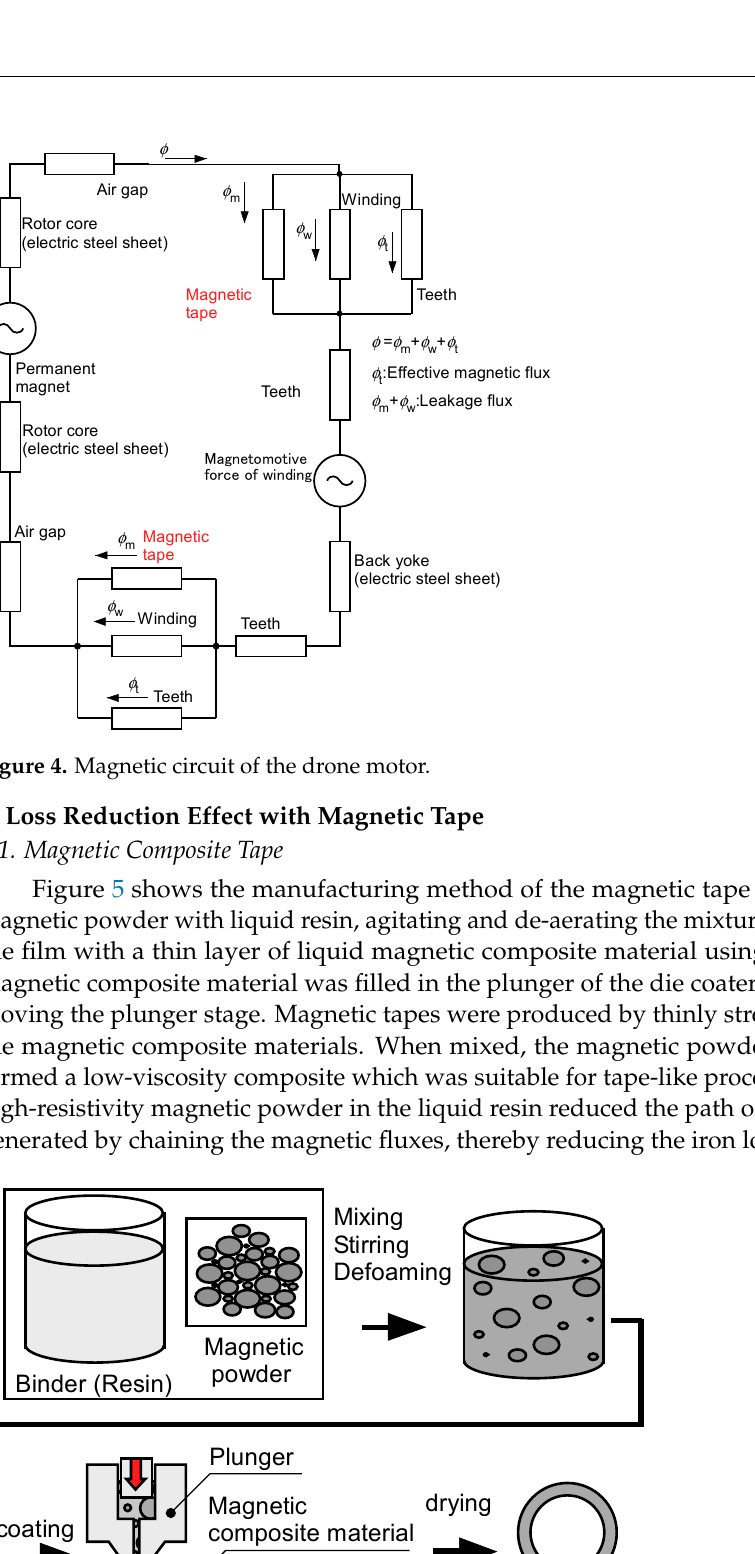
Figure 4. Magnetic circuit of the drone motor.